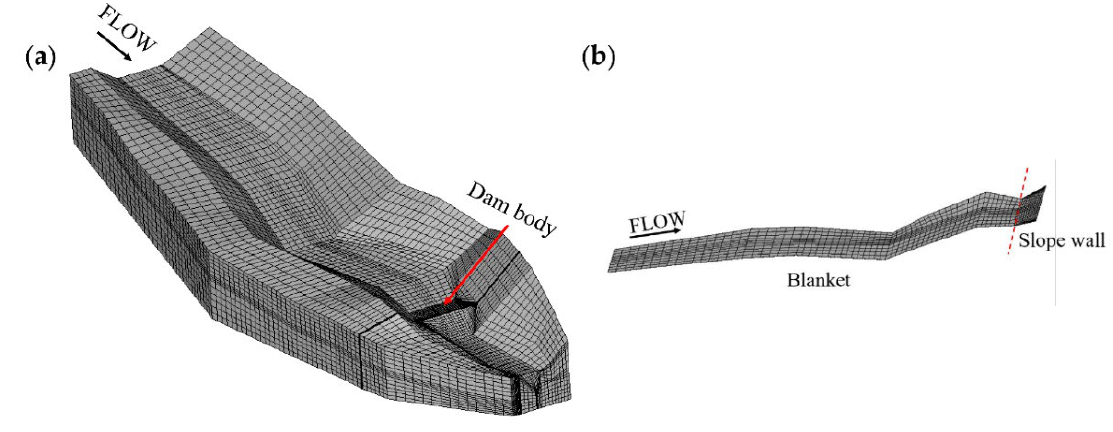
Figure 8. Finite element mesh models: ( a ) the whole dam; ( b ) the compound geomembrane.